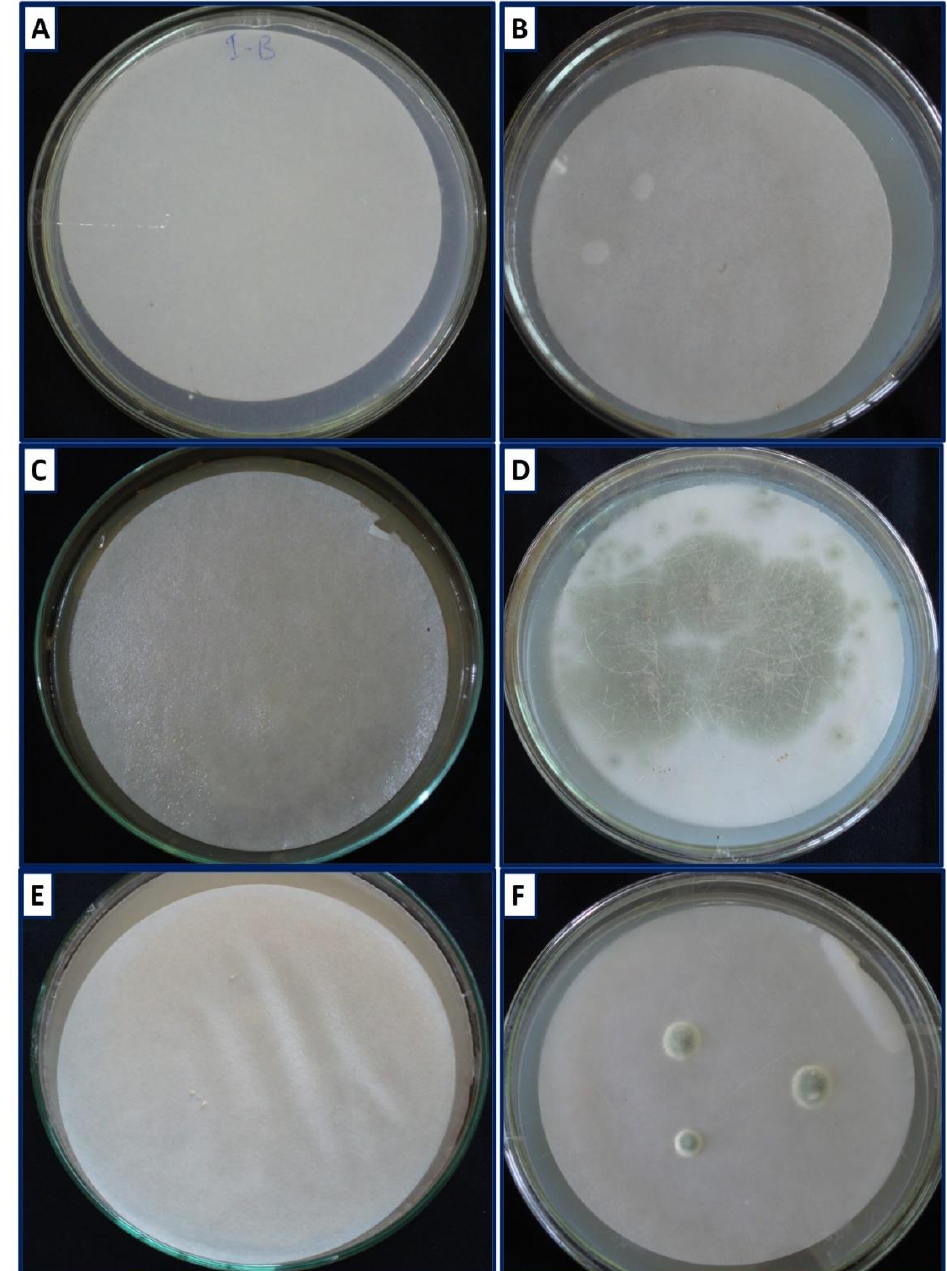
Figure 3. Photographic images for Whatman filter paper without any treatment ( A ), treated with 80 µg mL −1 without microbial inoculation ( B ), untreated filter paper inoculated with B. subtilis B3 and P. chrysogenum F9 ( C , D respectively), and treated filter paper inoculated with B. subtilis B3 and P. chrysogenum F9 after 21 days of aging ( E , F,